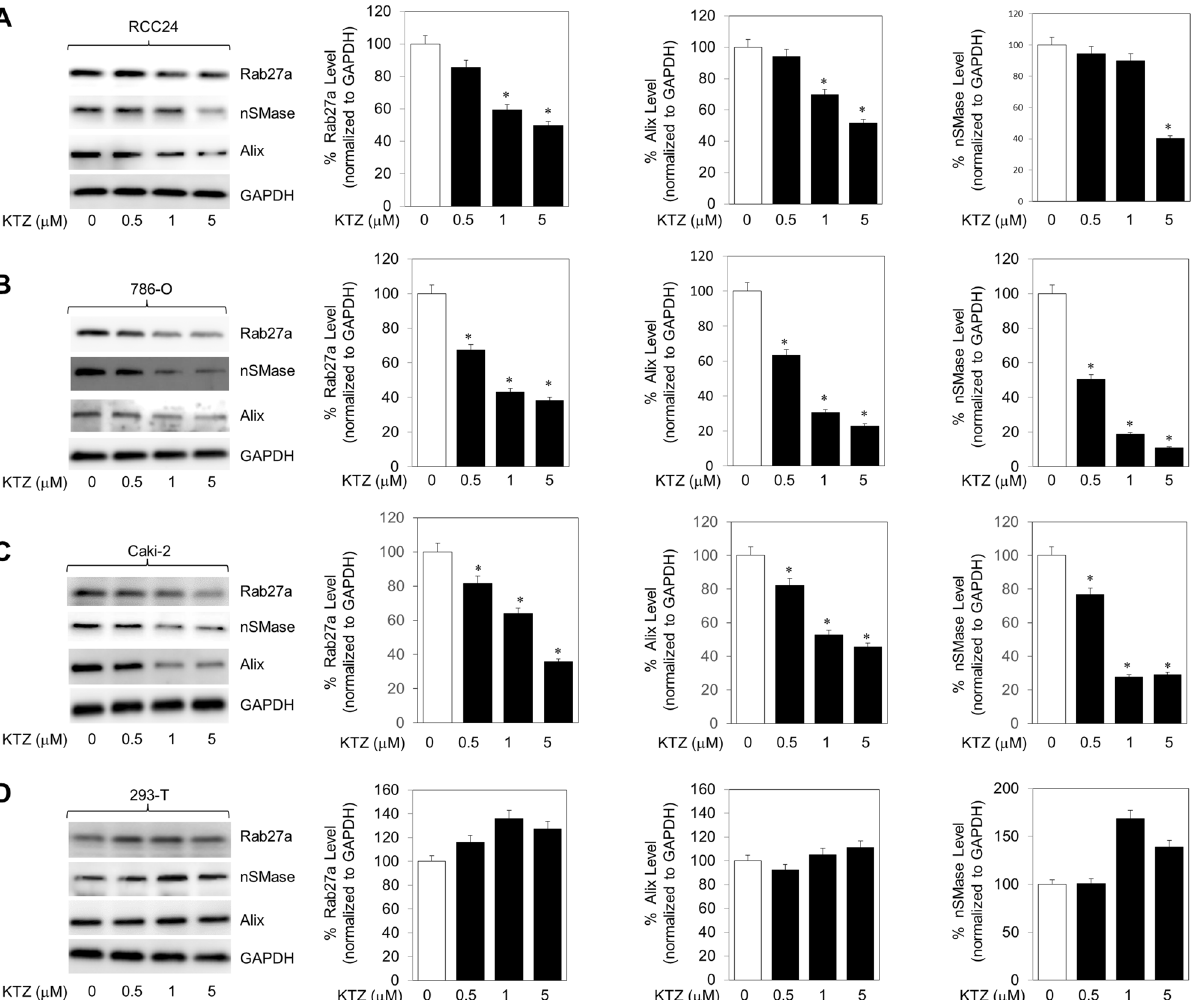
Figure 2. KTZ (prototype imidazole) inhibits exosome biogenesis through ESCRT dependent and independent pathway. KTZ significantly inhibited the protein expression of Alix, nSMase and Rab27a in a dose-dependent manner in RCC-24 ( A ), 786-O ( B ), and Caki-2 ( C ) cells but not in the normal HEK 293-T cells ( D ). Full blots are presented in Supplementary Fig. S6. *Denotes significance at p < 0.05 compared to controls and was calculated using GraphPad